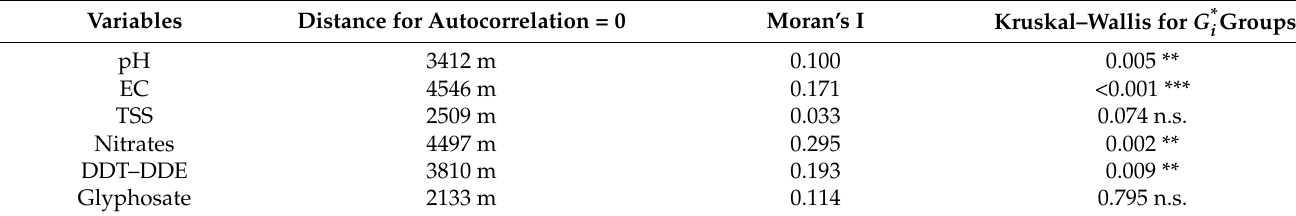
Table 3. Results from the spatial correlogram, local Moran’s I, and Kruskal–Wallis